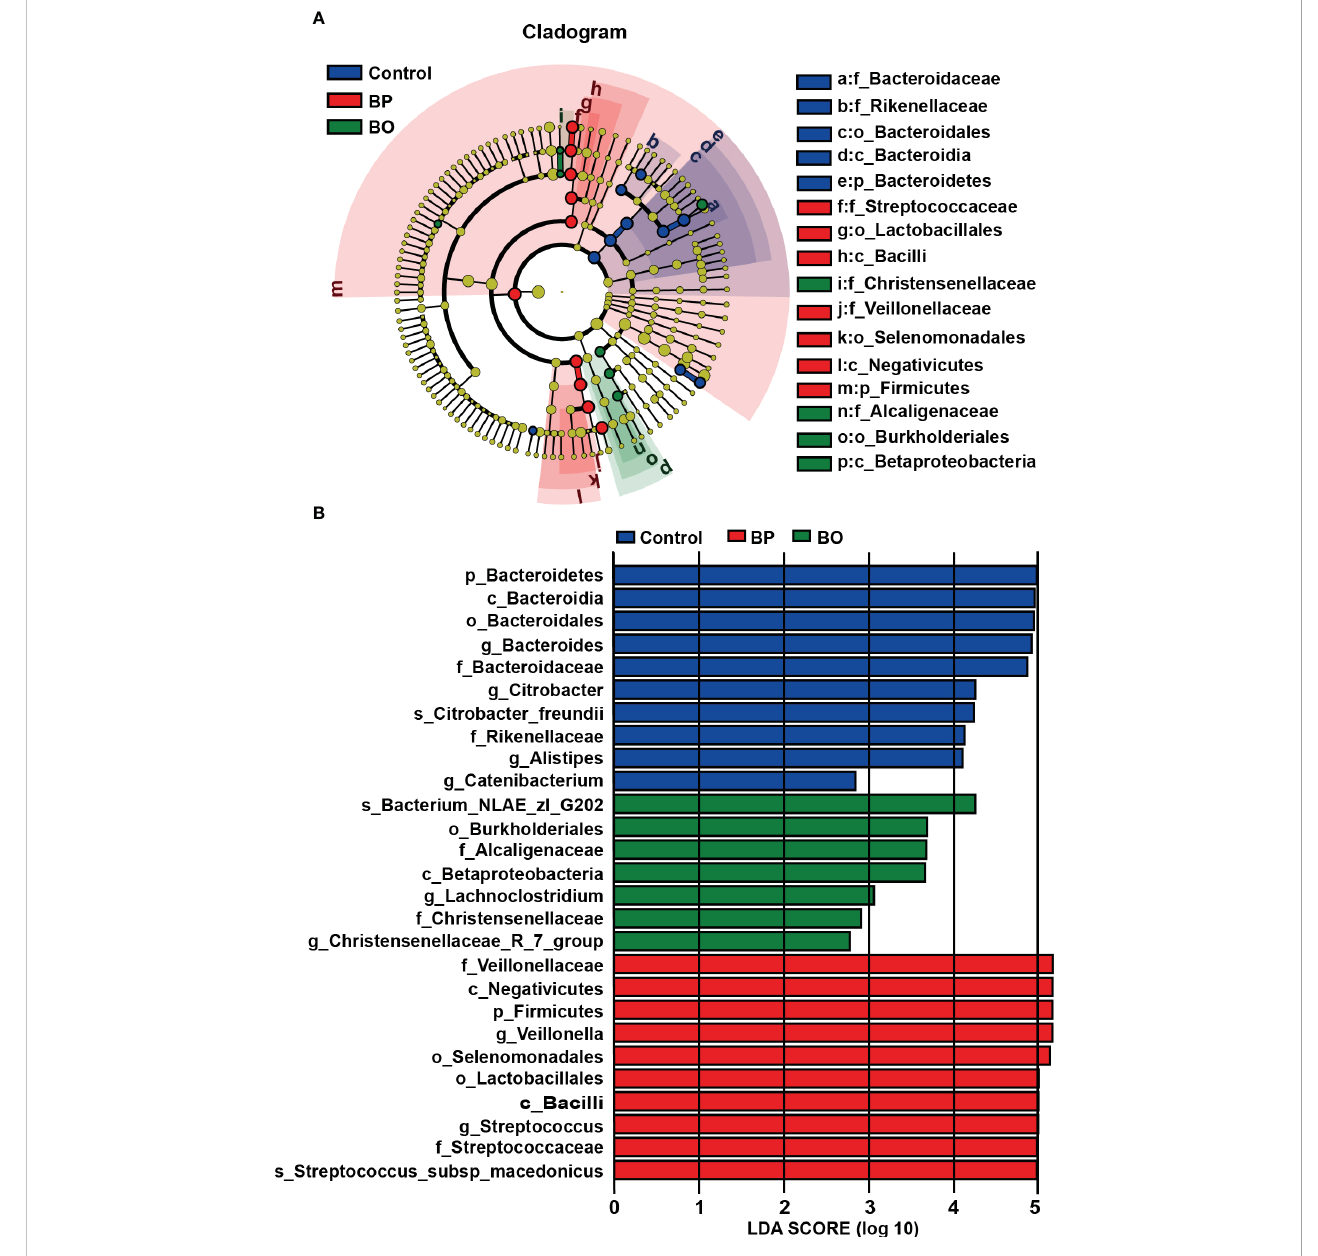
FIGURE 6 Identi fi cation of most characteristic taxa among three experimental groups by linear discriminant analysis (LDA) effect size (LEfSe). (A) Taxonomic cladogram obtained from LEfSe analysis on gut microbiota in individual experimental groups. (B) LDA scores calculated for taxa differentiation among experimental